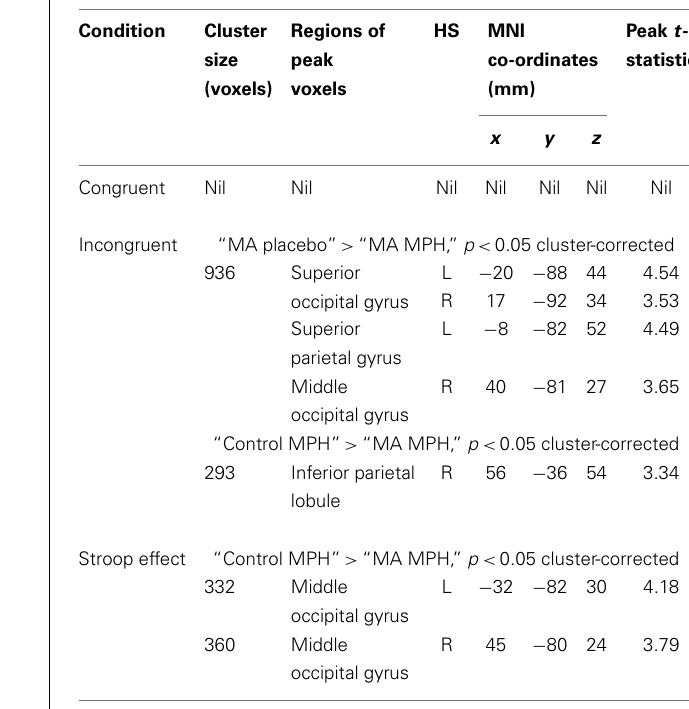
Table 5 |Whole-brain 2 × 2 between-subjectANOVA analyses of group differences in blood-oxygen-level-dependent activation during the three Stroop conditions